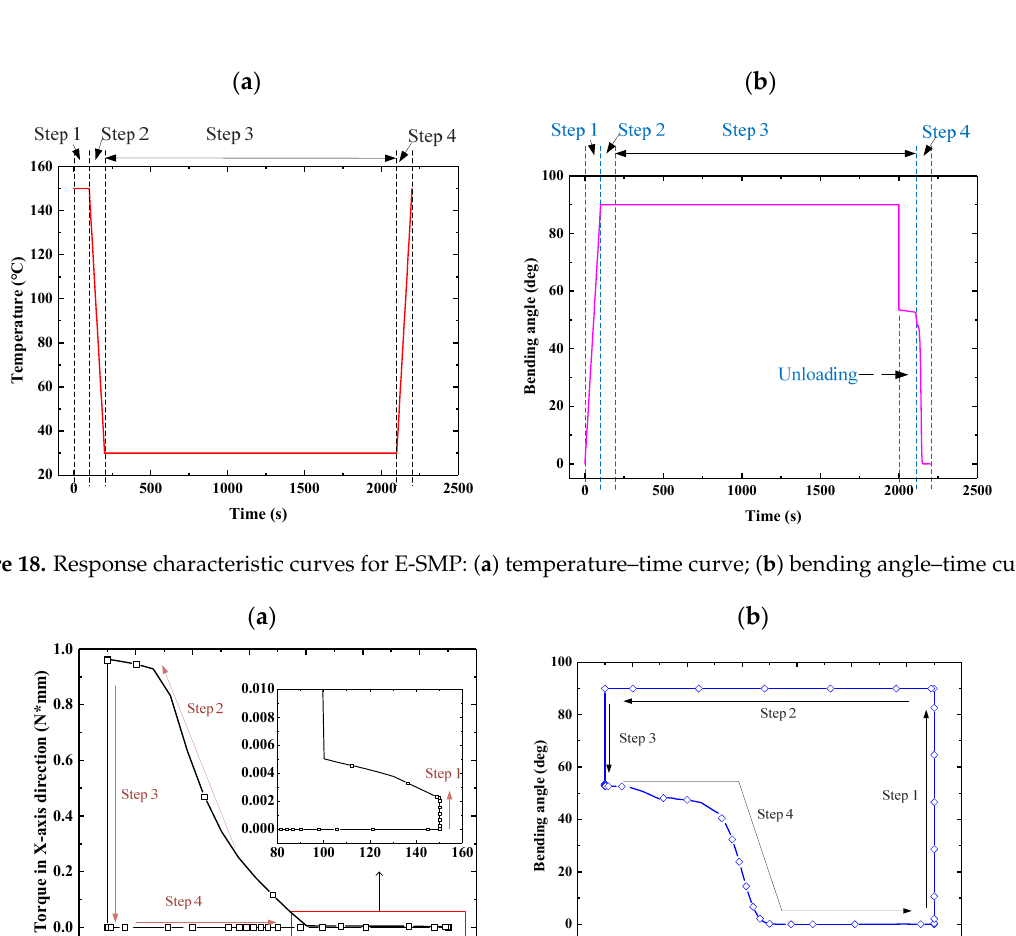
Figure 19. Shape memory characteristic diagram for E-SMP: ( a ) X -axis direction–temperature curves; ( b ) bending angle–temperature curve.